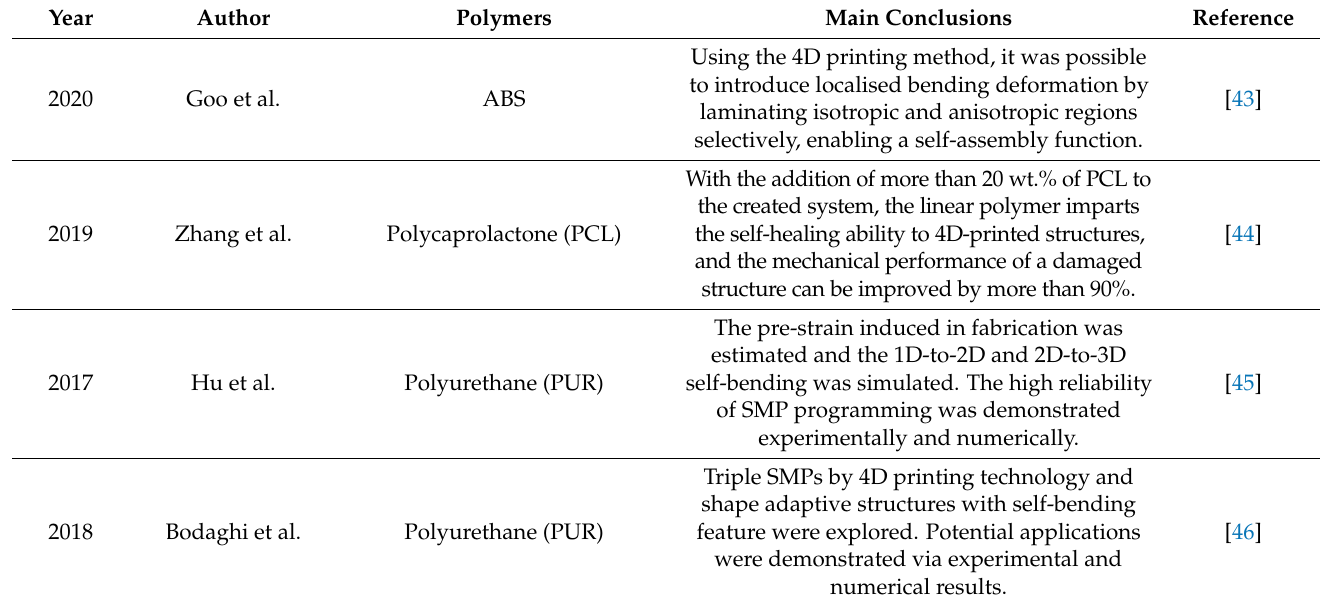
Table 1. Studies related to shape memory polymers printed via